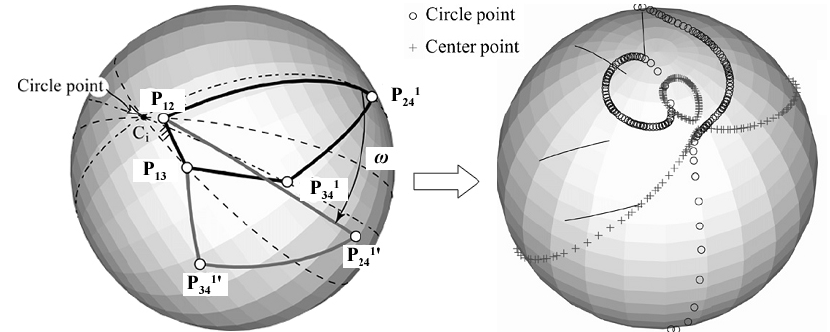
Figure 2. Principle of the spherical 4R linkage synthesis (reproduced from Shirazi, 2007).